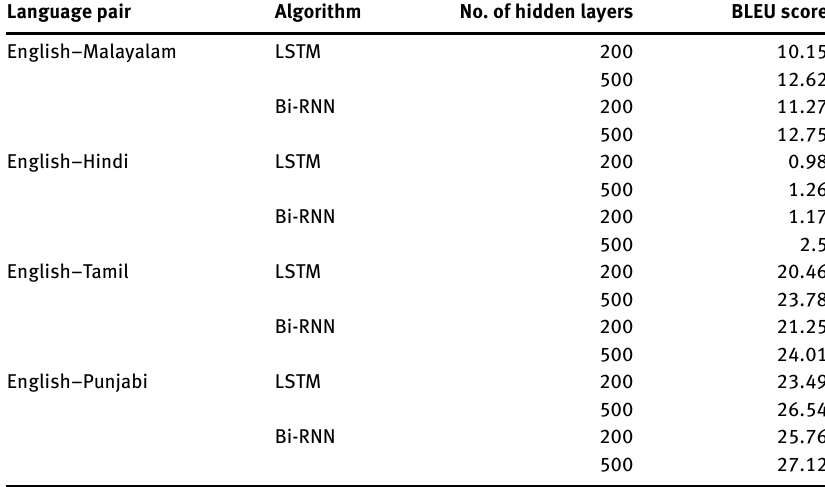
Table 9: BLEU Scores of